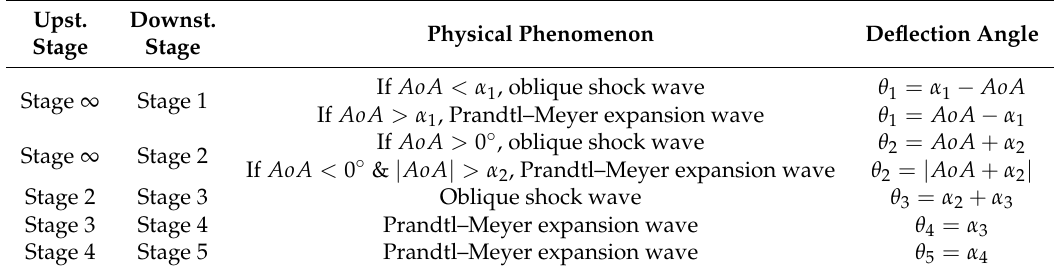
Table 1. Deflection angle and physical phenomenon between the different